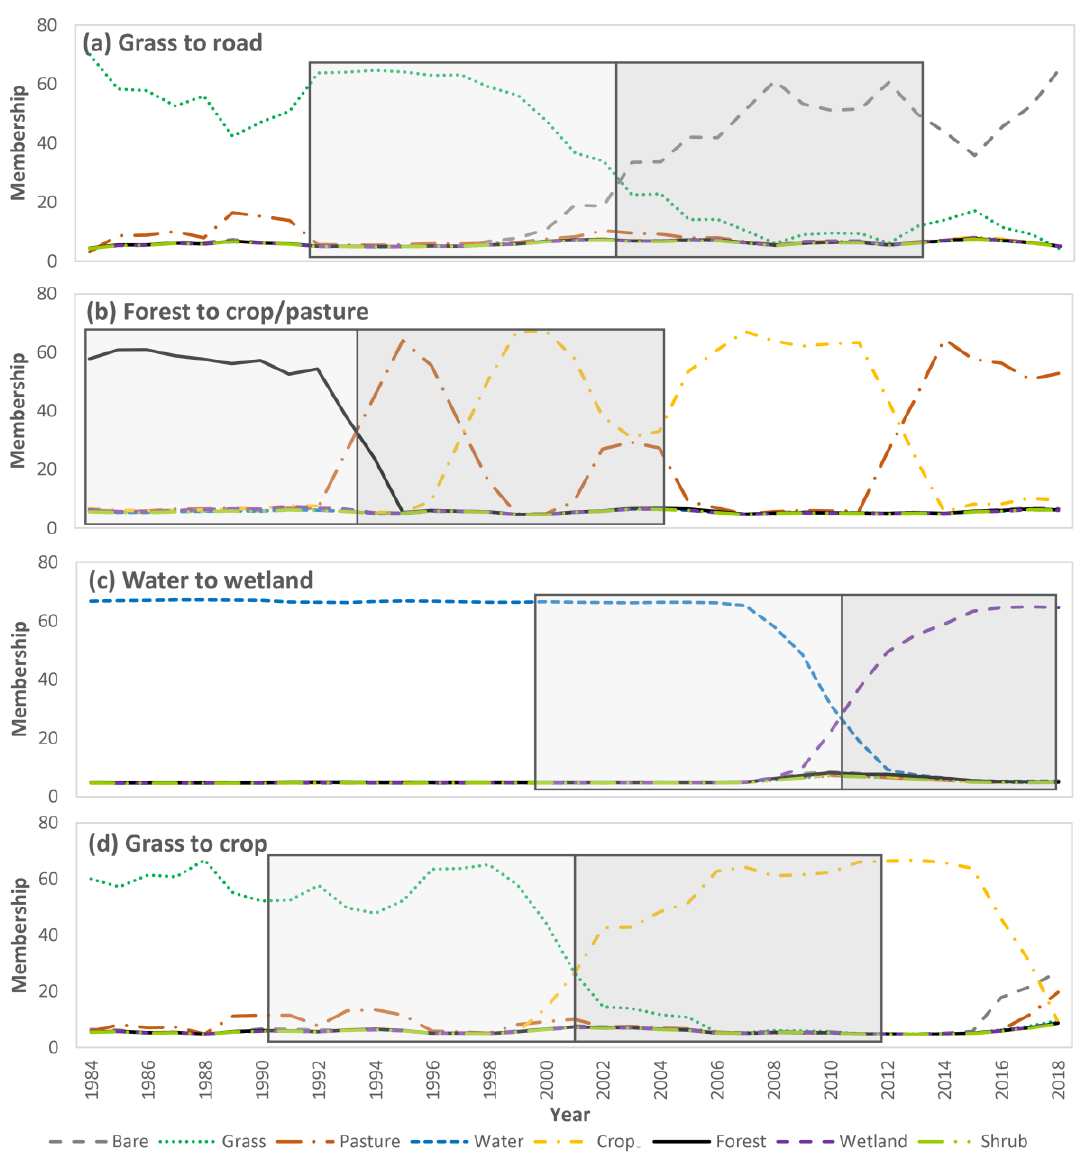
Figure 4. Example membership time series for selected pixels ( a – d ) showing the to and from windows associated with a detected change